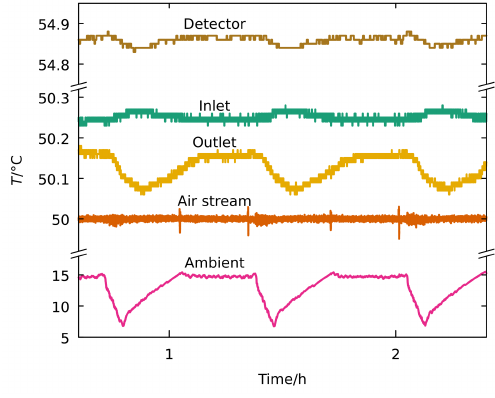
Figure 9. Temperatures inside and outside COCAP under simulated flight conditions (depicted in Fig. 8a and b). The temperature sen- sors in the detector, inlet and outlet of the CO 2 sensor are uncal- ibrated; hence they have an unknown offset of up to 1.1 ◦ C. The detector is about 5K warmer than the other parts (note the broken temperature axis) due to heat transfer from the component block which is heated to 55 ◦ C. Ambient temperature is plotted at a dif- ferent scale as it varies 2 orders of magnitude more than the sta- bilised internal temperatures. The spikes in air stream temperature are related to fast pressure changes in the environmental chamber (see Fig.